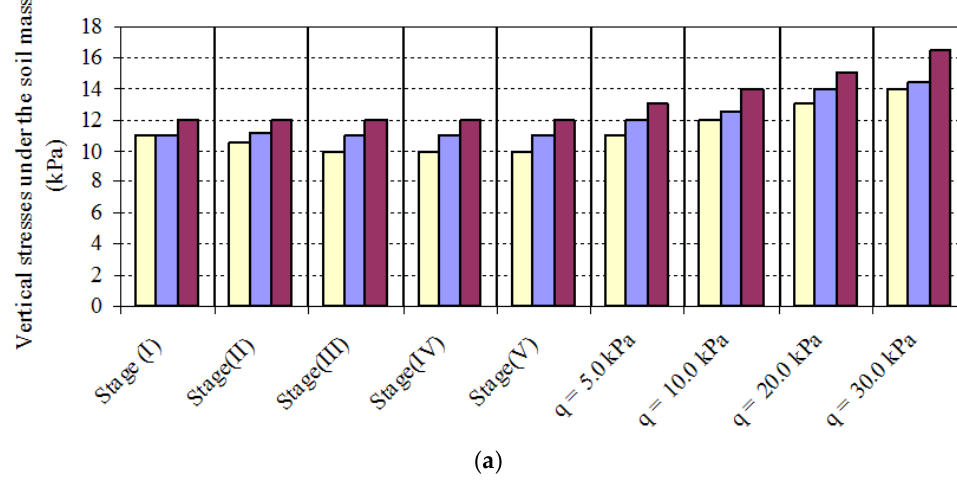
28 of 31 Figure 34. Footing settlement from laboratory and numerical models of nailed soil slope.